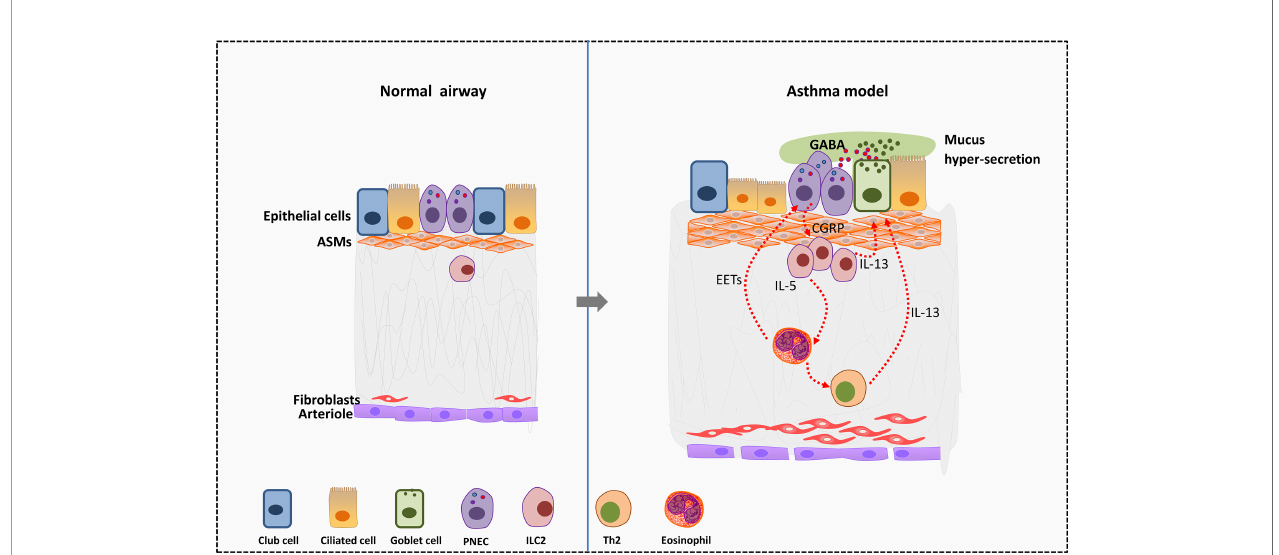
FIGURE 2 | Effects of PNEC cells on surrounding cells in allergic asthma. In murine asthma model, PNECs secret CGRP to active ILC2s and further promote the differentiation of Th2 cells. Type 2 cytokines such as IL-5 and IL-13 secreted by ILC2s act on eosinophils and goblet cells. Eosinophils in turn activate PNECs by releasing EETs. Besides, PNECs secret GABA to promote transformation of club cells near PNECs into goblet cells. GABA leads to excess mucus secretion in airway goblet cells by acting on GABA type a and GABA type b receptors, thus worse symptoms in asthma. EETS, Eosinophil extracellular traps; PNECs, pulmonary neuroendocrine cells; GABA, gamma-aminobutyric acid; ASMs, airway smooth muscle